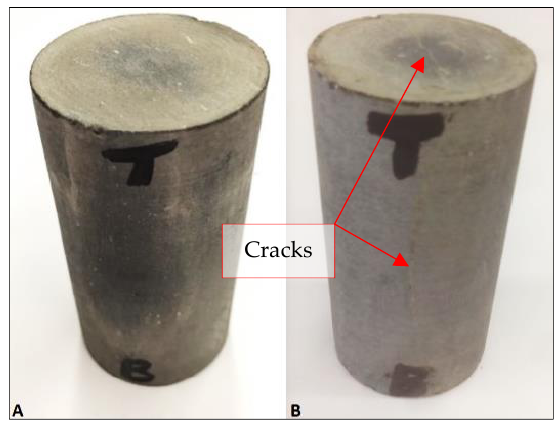
Figure 11. Core sample SH#5 ( A ) BTS; and ( B ) after 2nd thermal shock.